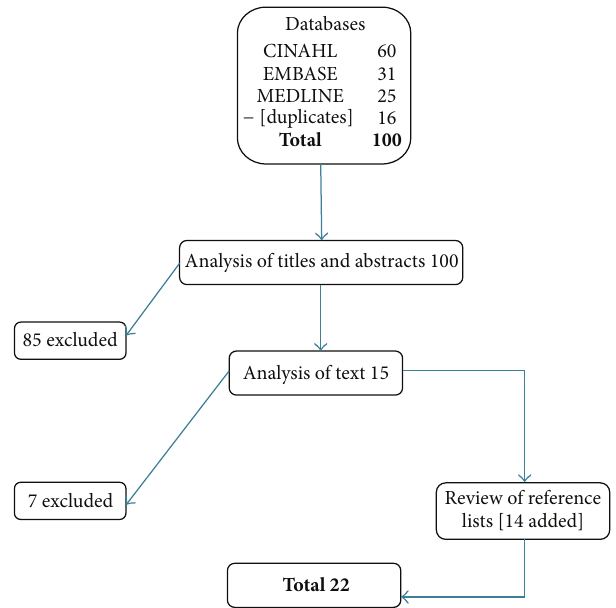
Figure 2: Data extraction and